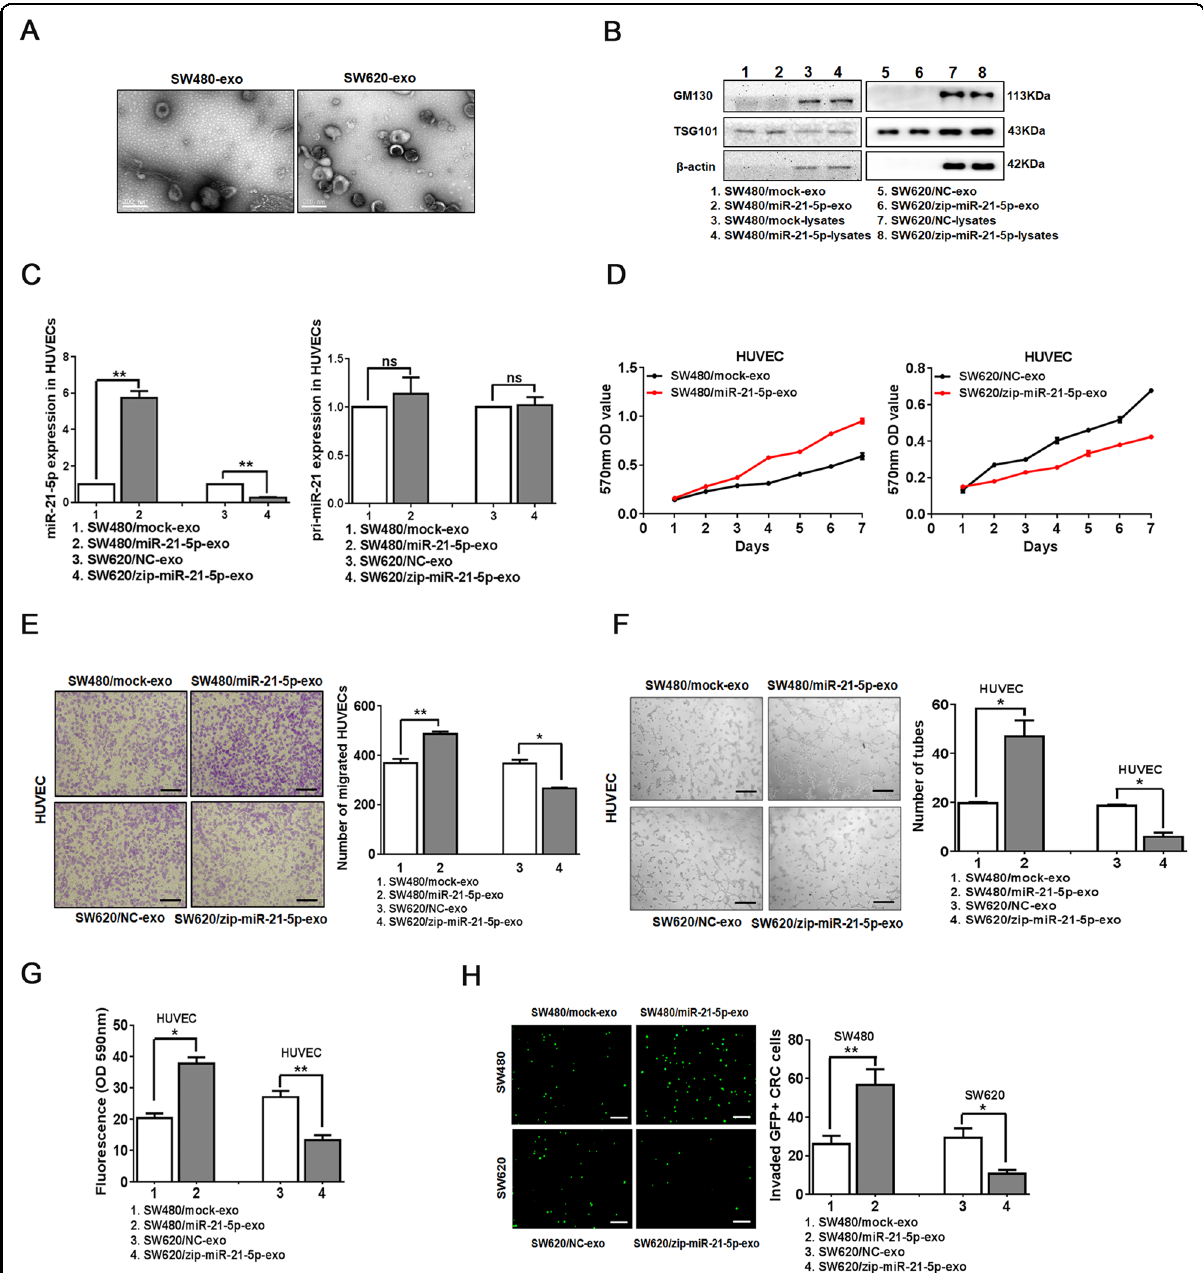
Fig. 2 CRC-secreted exosomal miR-21-5p is transferred to endothelial cells and induces angiogenesis and vascular permeability in vitro. A Transmission electron microscopy of exosomes derived from SW480 and SW620. Scale bars represent 200 nm. B Expression of GM130 and TSG101 in cell lysates or exosomes extracted from SW480/mock, SW480/miR-21-5p, SW620/NC, or SW620/zip-miR-21-5p by Western blot. Expression levels were normalized to β -actin. C Expression of miR-21-5p and pri-miR-21 in HUVECs incubated with exosomes derived from SW480/mock, SW480/miR- 21-5p, SW620/NC, or SW620/zip-miR-21-5p by qRT-PCR. Mean ± SEM are provided ( n = 3). D Effect of SW480/mock exosomes, SW480/miR-21-5p exosomes, SW620/NC exosomes, and SW620/zip-miR-21-5p exosomes on the proliferation of HUVECs. Mean ± SEM are provided ( n = 3). E Effect of SW480/mock exosomes, SW480/miR-21-5p exosomes, SW620/NC exosomes, and SW620/zip-miR-21-5p exosomes on the migration of HUVECs by Boyden chamber. Scale bars represent 50 µm. Mean ± SEM are provided ( n = 3). F Effect of SW480/mock exosomes, SW480/miR-21-5p exosomes, SW620/NC exosomes, and SW620/zip-miR-21-5p exosomes on tube formation ability of HUVECs. Scale bars represent 50 µm. Mean ± SEM are provided ( n = 3). G Effect of SW480/mock exosomes, SW480/miR-21-5p exosomes, SW620/NC exosomes, and SW620/zip-miR-21-5p exosomes on the permeability of the HUVEC monolayers to rhodamine-dextran by in vitro permeability assay. Mean ± SEM are provided ( n = 3). H The number of GFP + CRC cells invaded through the HUVEC monolayers pre-treated with SW480/mock exosomes, SW480/miR-21-5p exosomes, SW620/NC exosomes, and SW620/zip-miR-21-5p exosomes. Scale bars represent 50 µm. Mean ± SEM are provided ( n = 3). * P < 0.05, ** P < 0.01, *** P < 0.001. NS represents no signi fi cant difference. Of fi cial journal of the Cell Death Differentiation